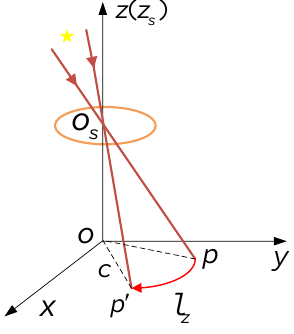
Figure 2. Model of star centroid when rotating around Z axis.